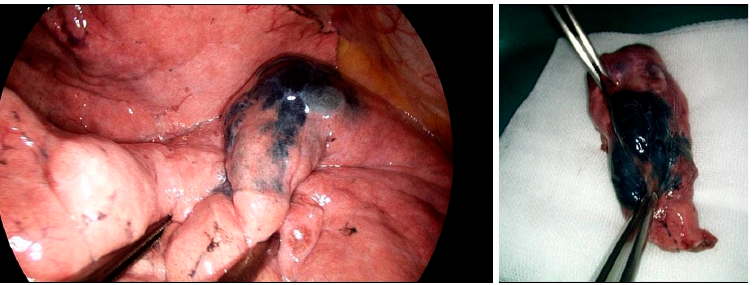
Figure 2. Video-assisted thoracoscopic image of nodule marked with MIL and resected lung. If localization is successful, the location can be easily identified through a video-assisted thoracoscopic image in the operating room.